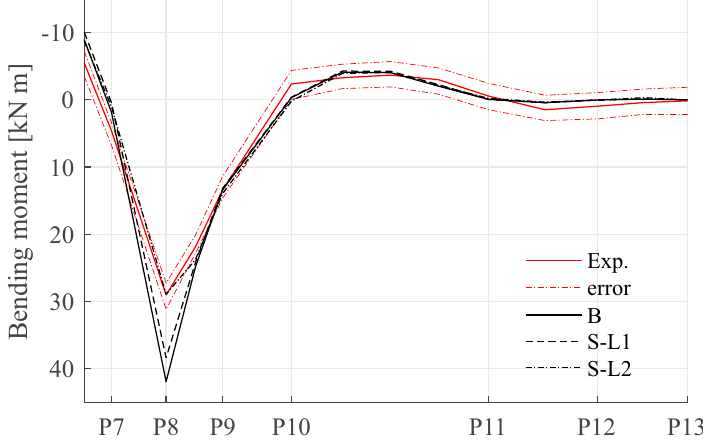
Figure 8. Bending moment influence line at P8.